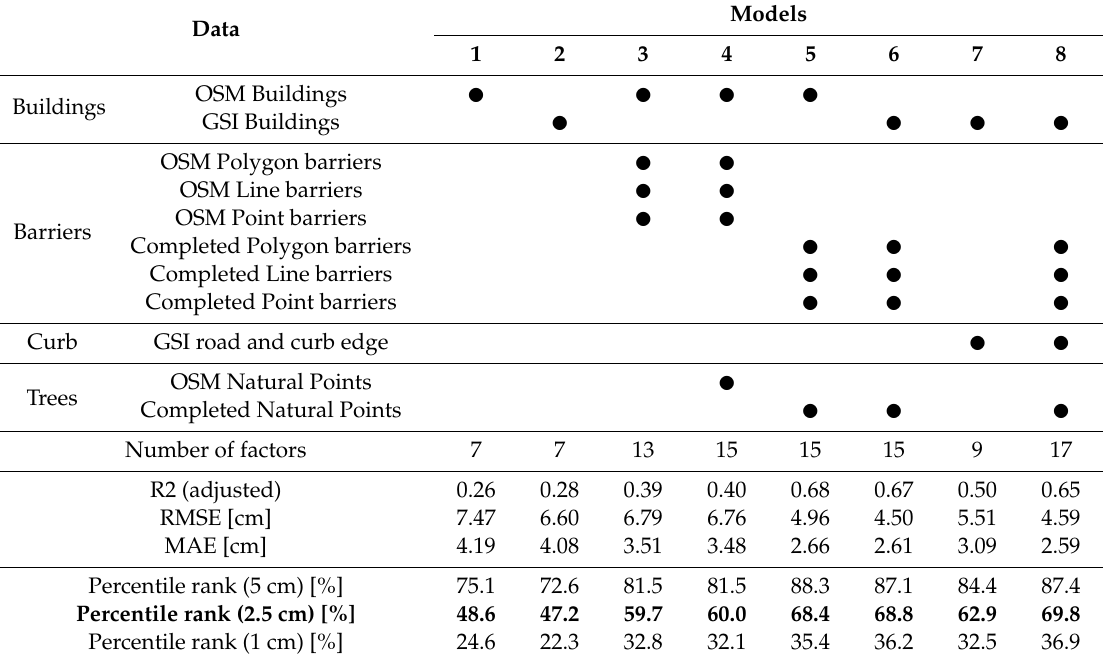
Table 4. Combination of data layers and the performance (accuracy) of the predictive models. Data